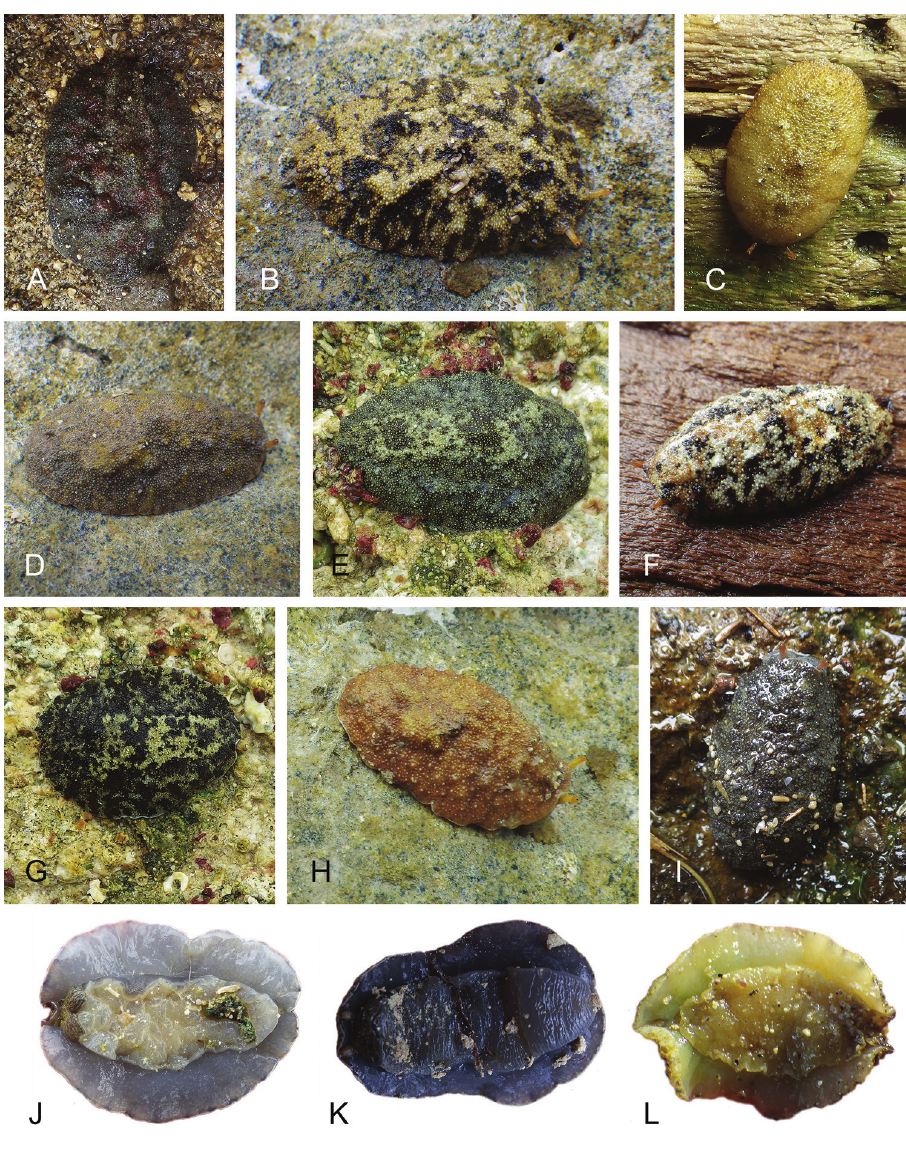
Figure 30. Live specimens, Wallaconchis nangkauriense . A Dorsal view, 28 mm long [3162], Philippines, Luzon (PNM 041204) B Dorsal view, 23 mm long [1786], Indonesia, Sumatra (UMIZ 00012) C Dorsal view, 18 mm long [2156], Indonesia, Sulawesi (UMIZ 00013) D Dorsal view, 23 mm long [1788], In- donesia, Sumatra (UMIZ 00012) E Dorsal view, 34 mm long [3269], Philippines, Bohol (PNM 041206) F Dorsal view, 24 mm long [2161], Indonesia, Sulawesi (UMIZ 00013) G Dorsal view, 32 mm long [3268], Philippines, Bohol (PNM 041206) H Dorsal view, 28 mm long [1787], Indonesia, Sumatra (UMIZ 00012) I Dorsal view, 24 mm long [3217], Philippines, Luzon (PNM 041205) J Ventral view, same as G K Ventral view, 28 mm long [3427], Philippines, Bohol (PNM 041208) L Ventral view, 22 mm long [2731], Indonesia, Ambon (UMIZ